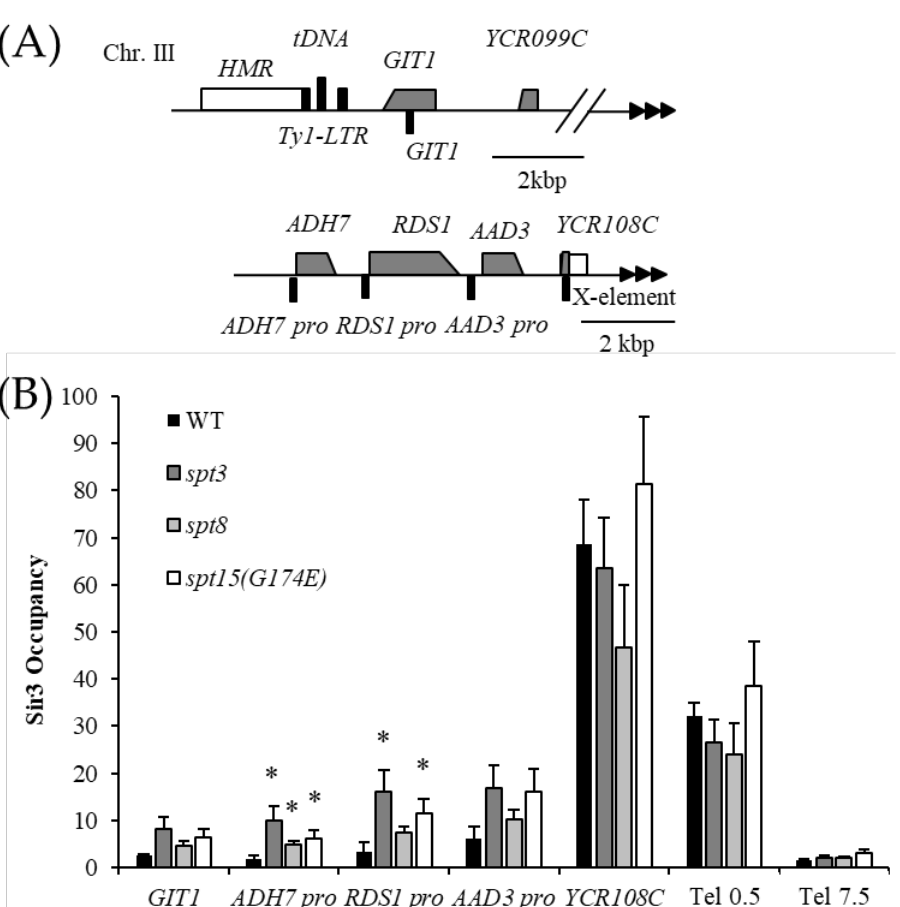
Figure 7. Silencing region was spread in spt3 ∆ , spt8 ∆ , and spt15 mutants. ( A ) Primer position for the ChIP assay. Black bars mean primer positions. ( B ) Occupancy levels of Sir3 in WT, spt3 ∆ , spt8 ∆ , and spt15(G174E) strain. Asterisks mean p < 0.15 compared with WT (Student’s T-test). Error bars show standard errors calculated from three independent experiments.